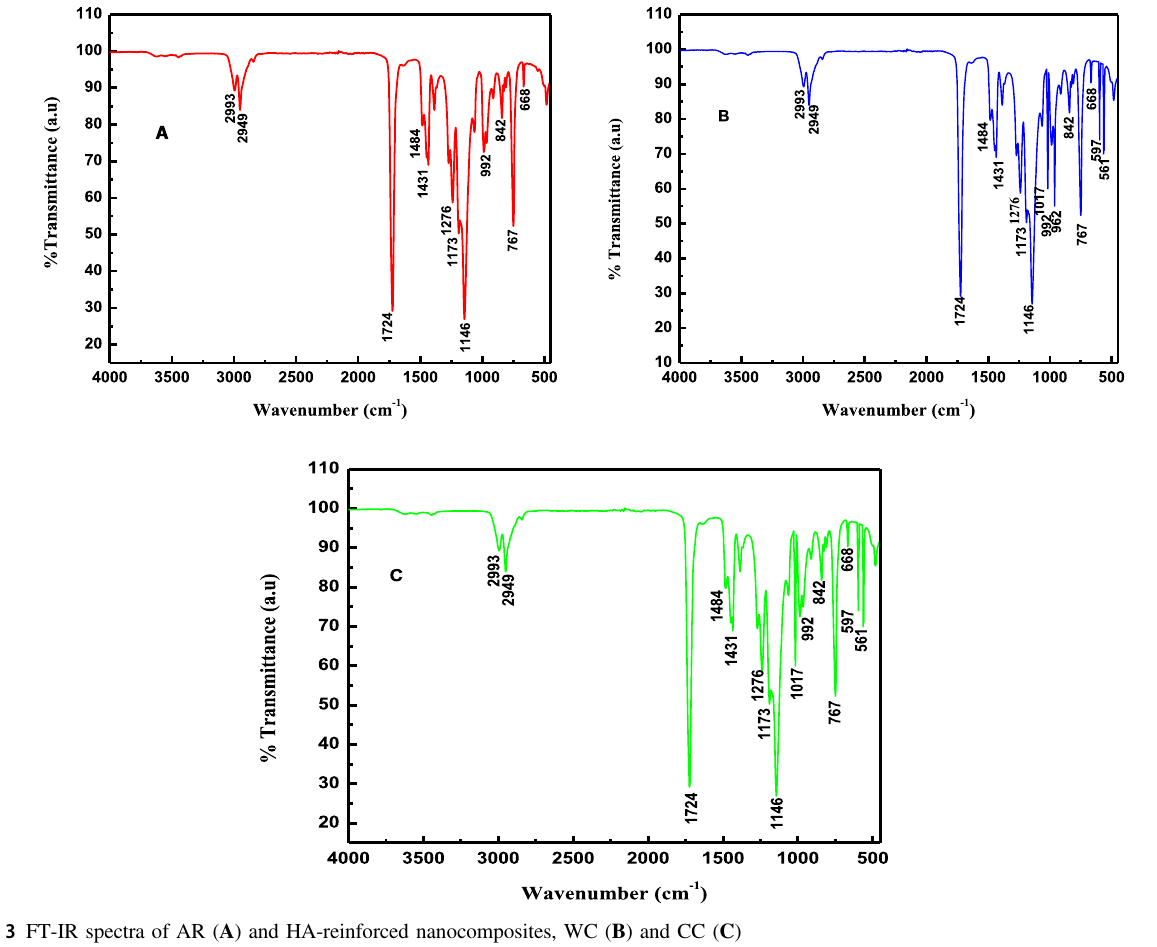
Fig. 3 FT-IR spectra of AR ( A ) and HA-reinforced nanocomposites, WC ( B ) and CC ( C )